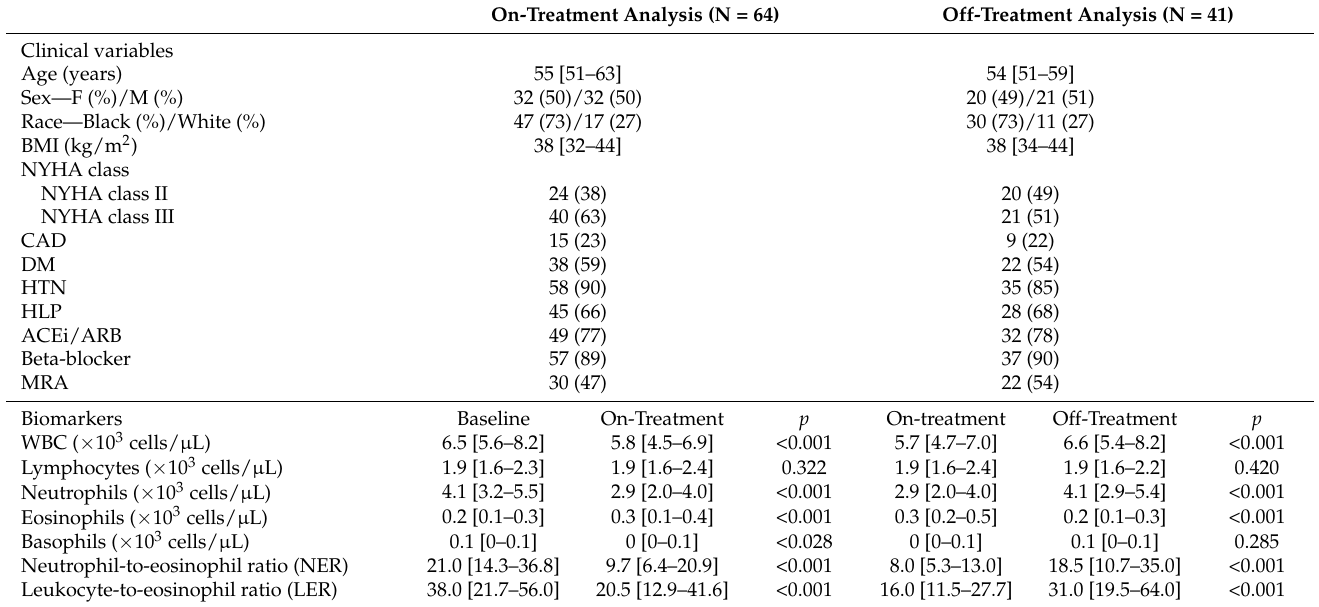
Table 1. Clinical characteristics of patients in the on-treatment and off-treatment analyses. On-Treatment Analysis (N = 64) Off-Treatment Analysis (N =